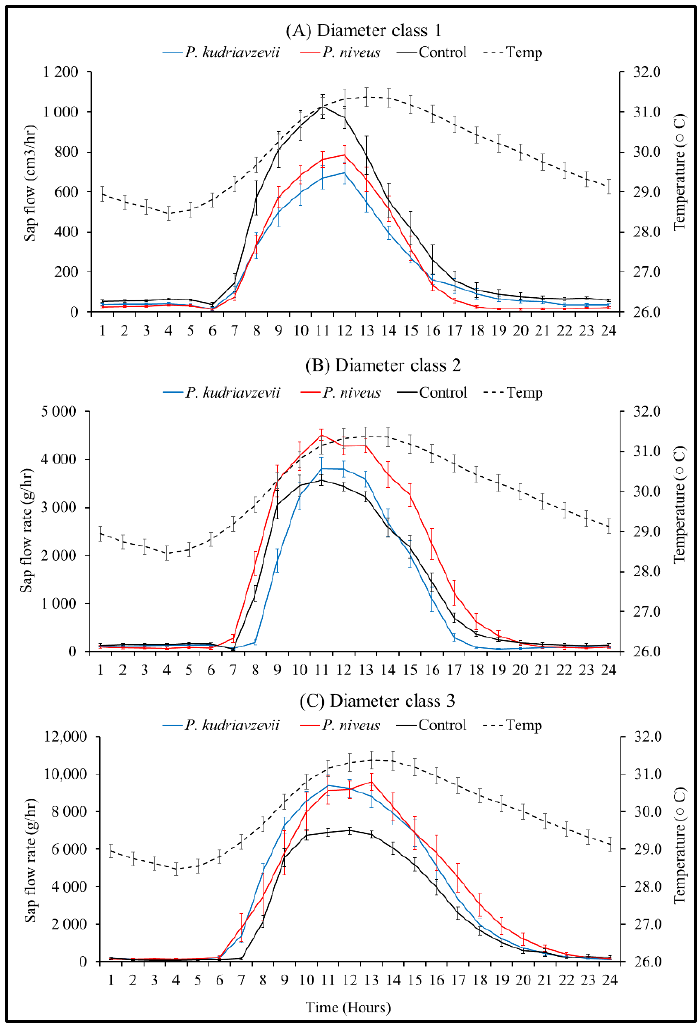
Figure 11. Diurnal SF rate of inoculated trees with fungi and uninoculated (control) A. malaccensis trees at ( A ) small-diameter class (DC1), ( B ) medium-diameter class (DC2), and ( C ) large-diameter class (DC3). The error bar represents the mean standard error (n =